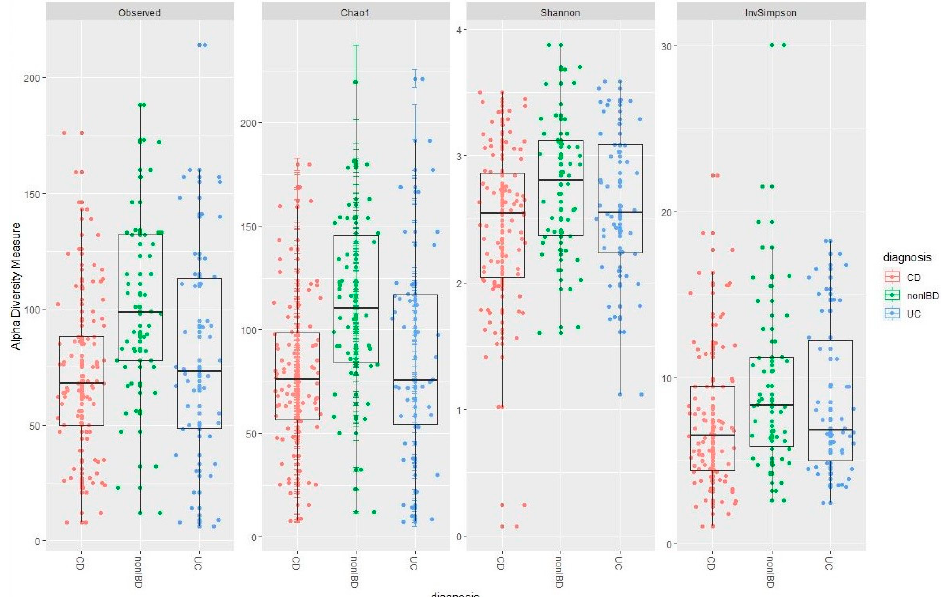
Figure 1. Comparison of α diversity measured by observed species, Chao1 index, Shannon diversity, and Simpson (from left to right). CD cluster is shown in red, UC in blue, and non-IBD subjects in green. Healthy control samples are significantly different from IBD samples. Shannon and Simpson indicate the uniformity of the abundance of different species in a sample. Figure generated using RStudio.